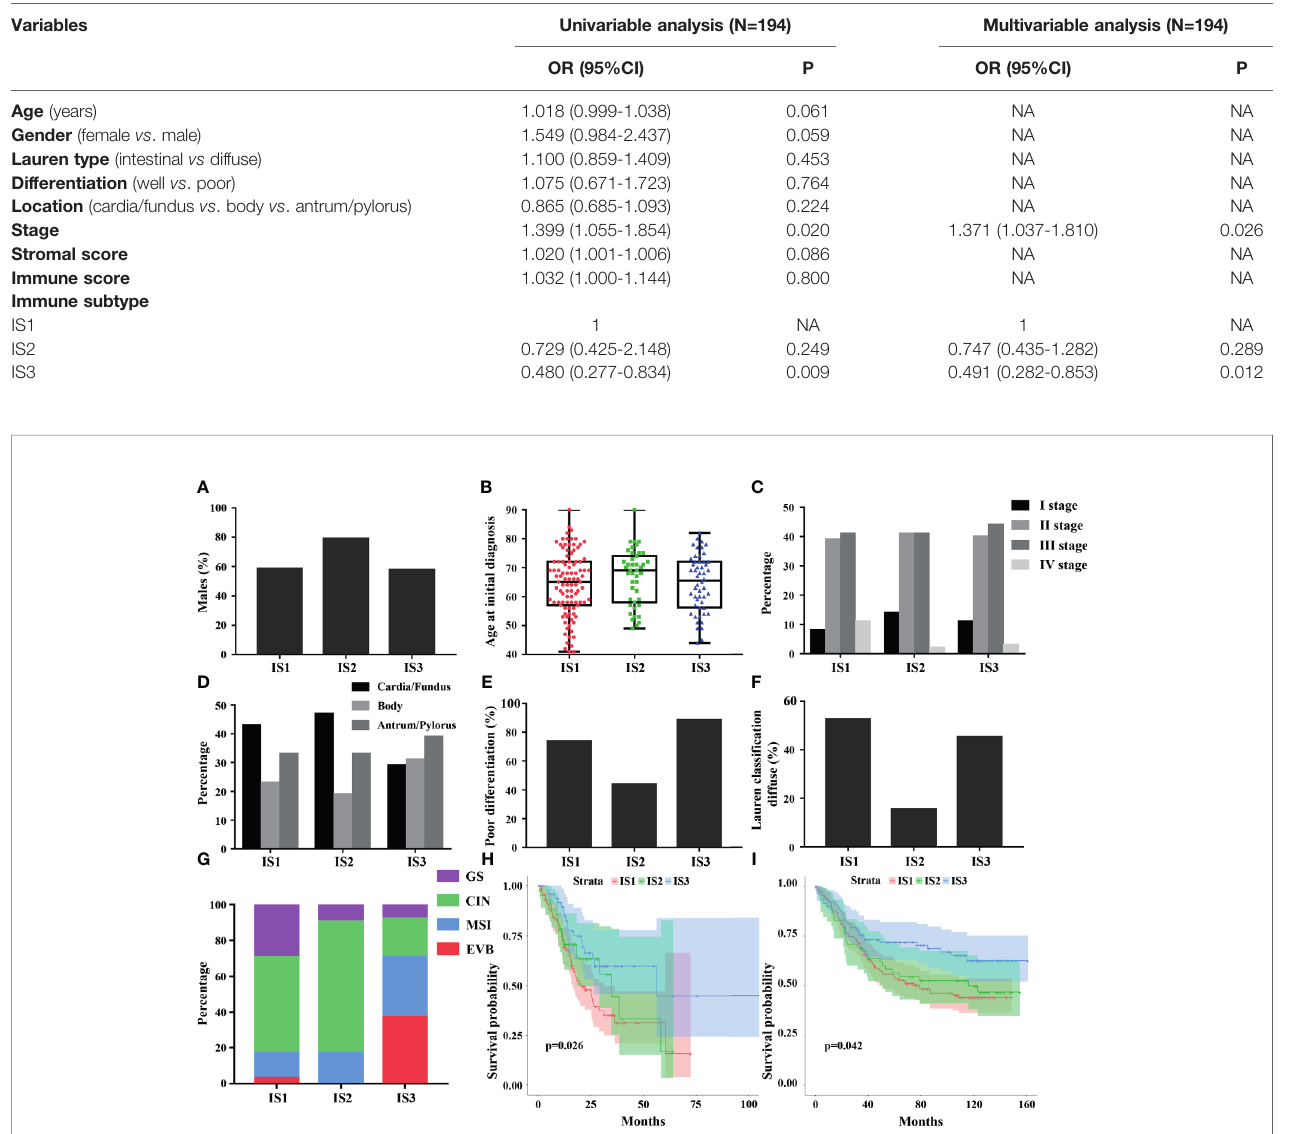
TABLE 3 | Univariable and multivariable analyses for overall survival in patients with gastric